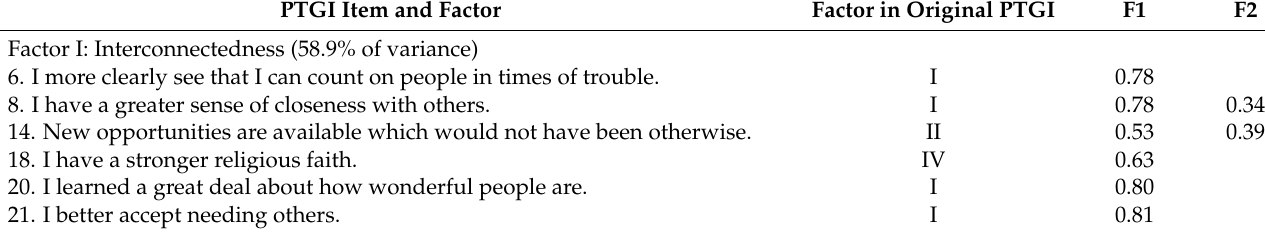
Table 1. Factor Loadings of 20 Posttraumatic Growth Inventory (PTGI) items. PTGI Item and